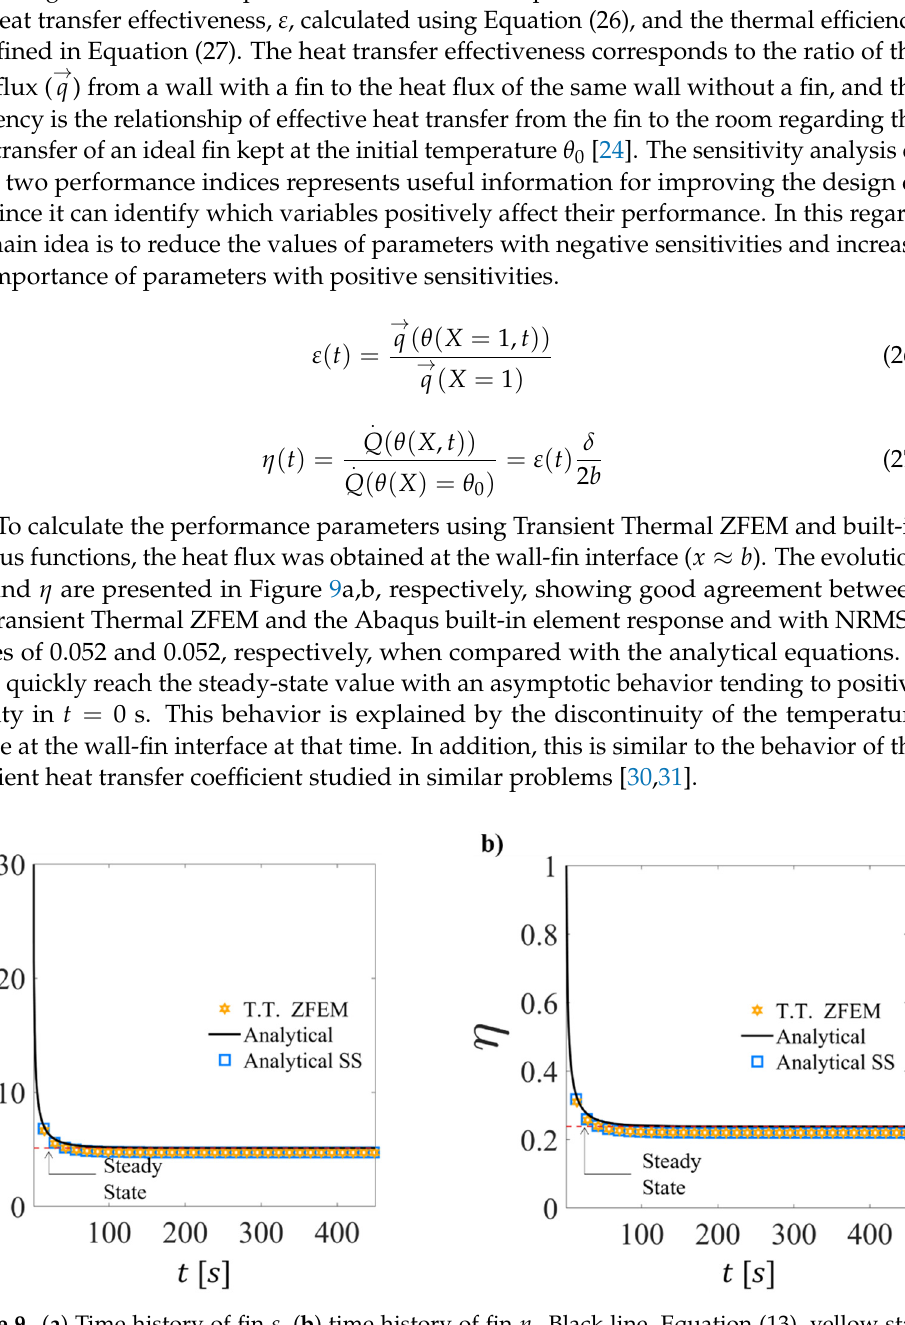
Figure 9. ( a ) Time history of fin 𝜀 , ( b ) time history of fin 𝜂 . Black line, Equation (13), yellow star, Transient Thermal ZFEM solution, blue square, Abaqus built-in element solution, black thin dashed line, black dashed line, the steady-state solution.